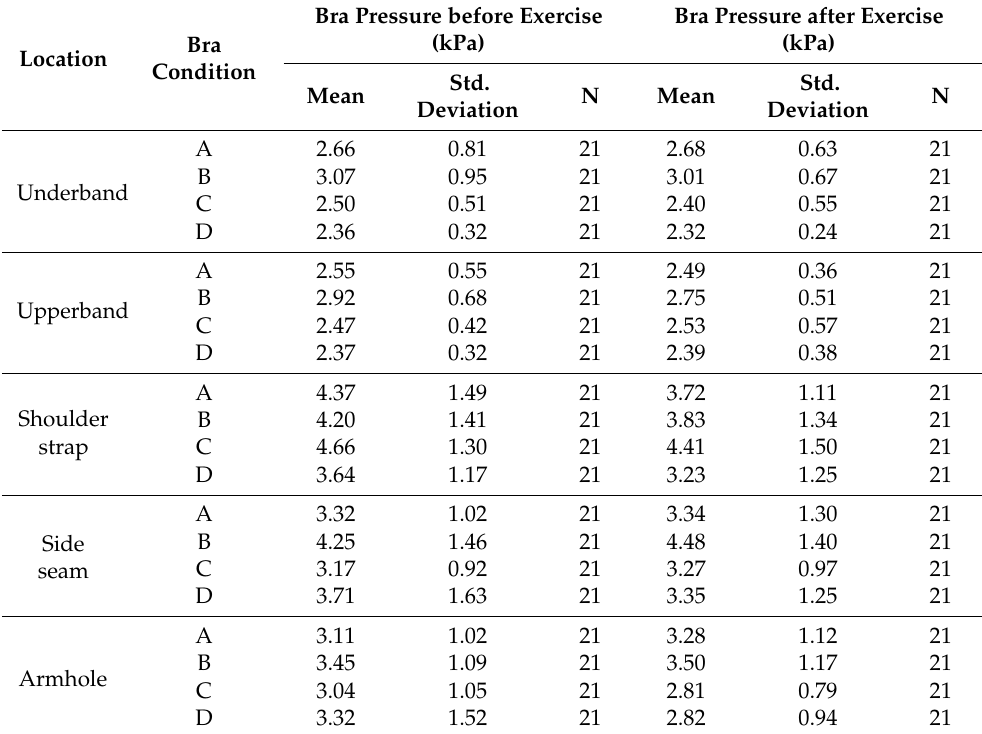
Table 3. Summary of descriptive statistics of bra pressure before and after exercising on treadmill.